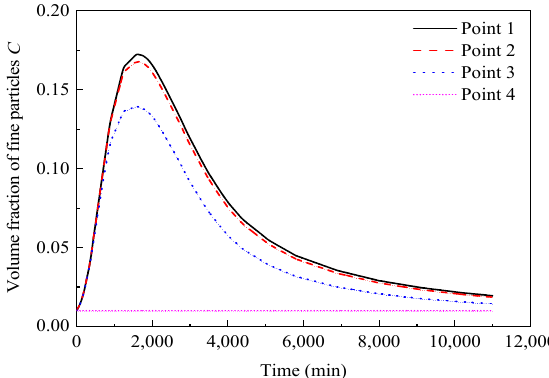
Figure 10. Evolution curves of the volume fractions of fine particles in saturated zone of railway subgrade.